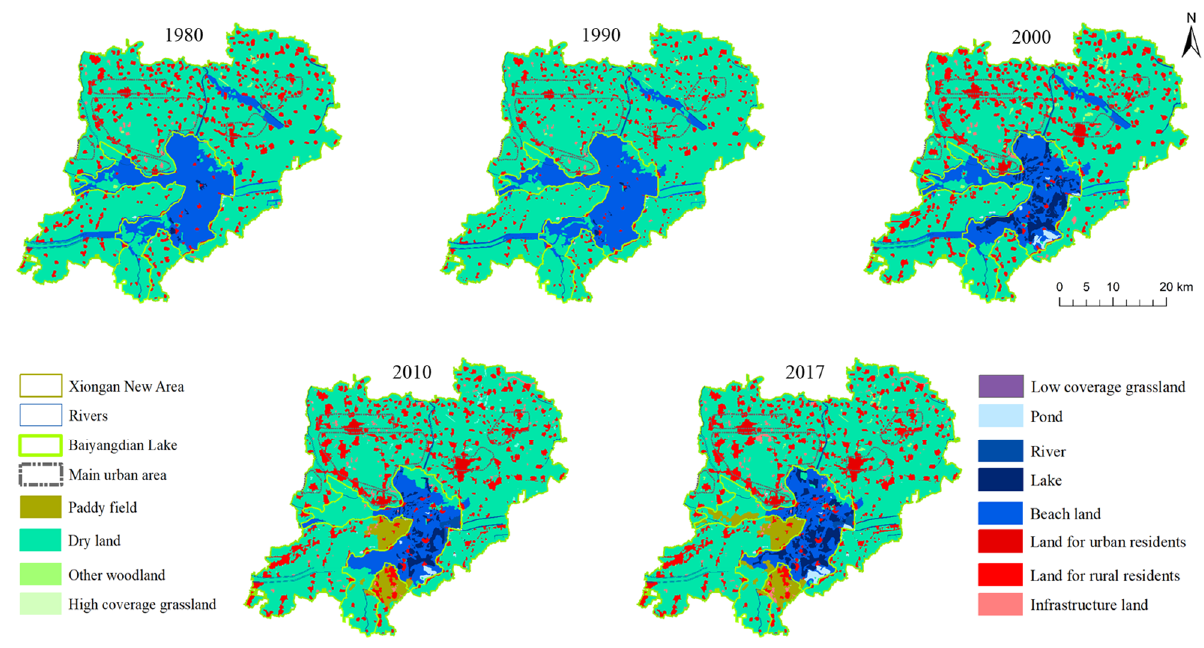
Figure 3. Spatial distribution of the landscape types in the Xiong’an New Area from 1980 to 2017.